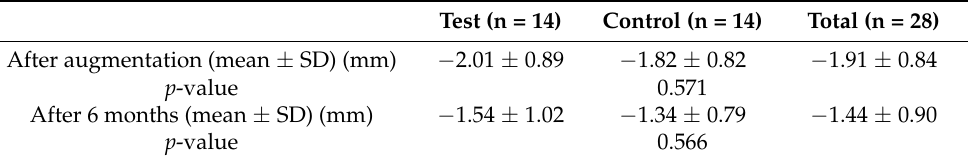
Table 4. Distance from the boundary line of the bony envelope to the hard tissue profile immediately after augmentation and after 6 months of healing.